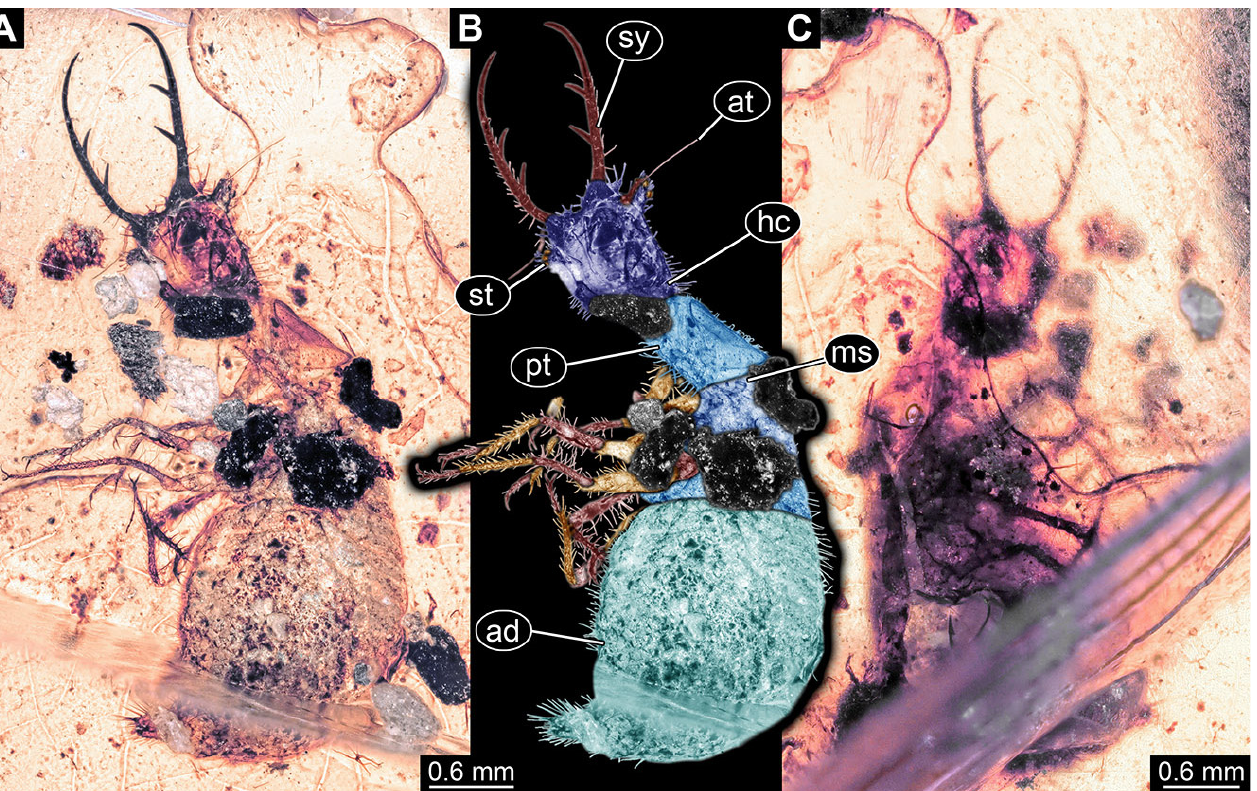
Figure 8. Fossil owllion larva, specimen 3219 (BUB 3380), Cretaceous Kachin amber, Myanmar. ( A ) Overview, oblique dorsal. ( B ) Color-marked version of ( A ). ( C ) Overview, oblique ventral. Abbreviations: ad = abdomen; at = antenna; hc = head capsule; ms = mesothorax; pt = prothorax; st = stemmata; sy = stylet.